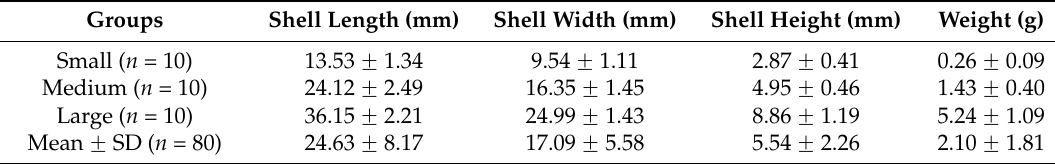
Table 1. Growth traits of Pacific abalones used for RNAseq transcriptome analysis. The sizes of 80 abalone spats 200 days post-fertilization were measured. The values (mean ± standard deviation) represent those from 10 abalones selected from small, medium, and large sized individuals for RNAseq analysis.